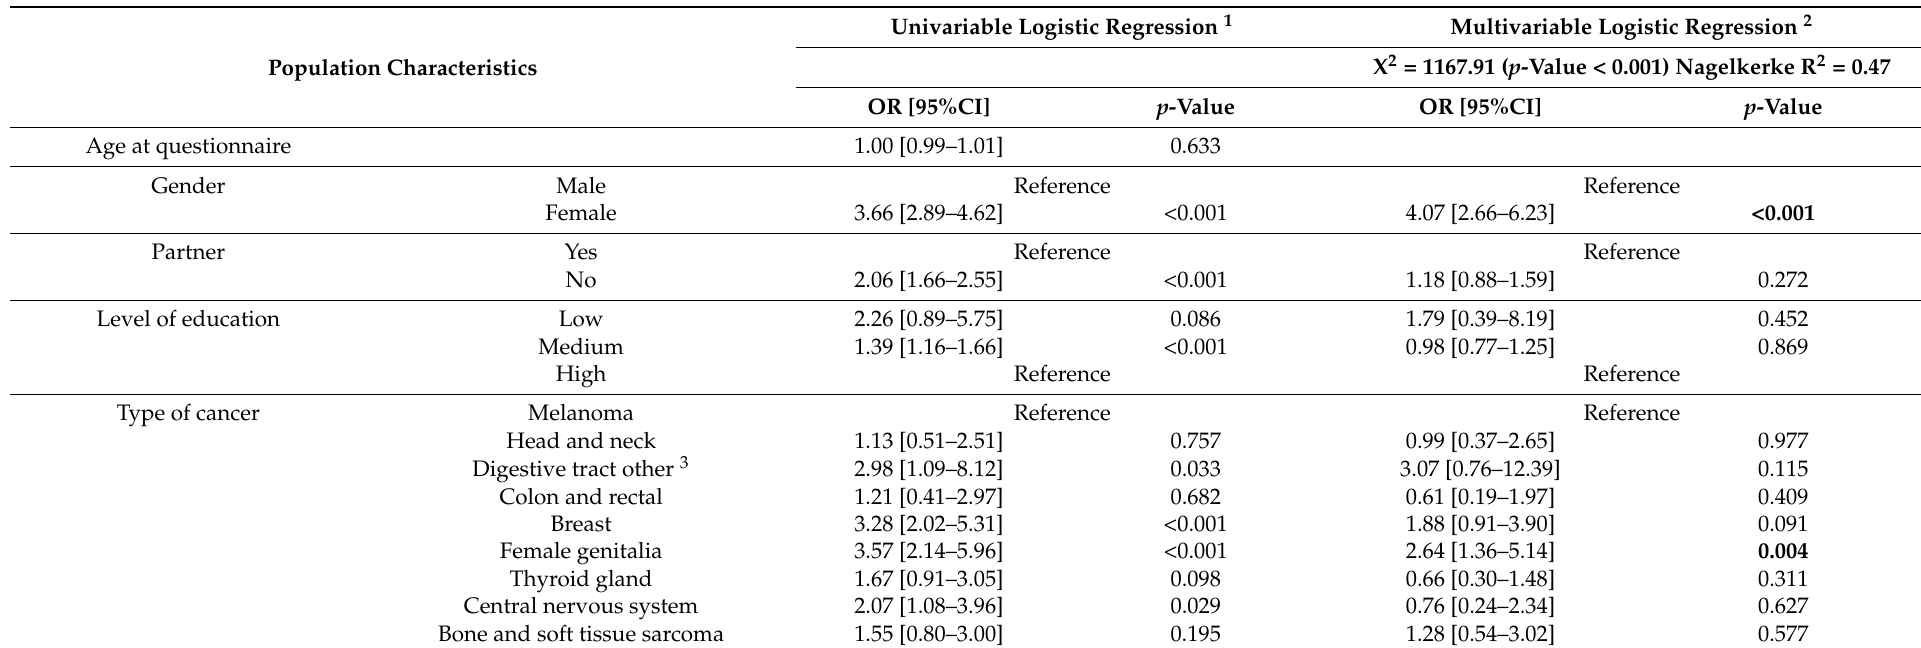
Table A2. Univariable and multivariable logistic regression without item on dissatisfaction with